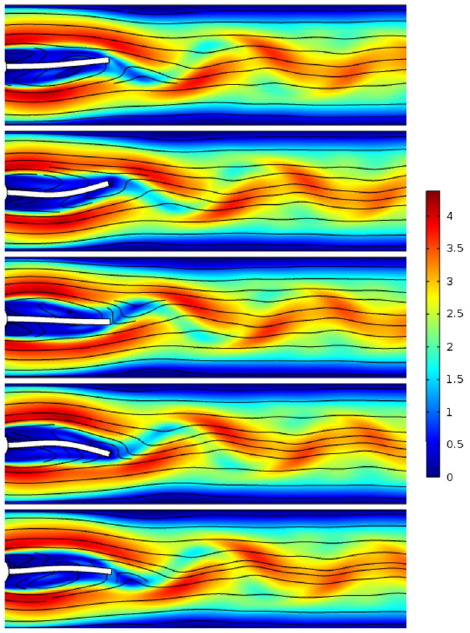
Fig. 10 Velocity field (m/s) and streamlines downstream of the channel for five different time steps for the best case